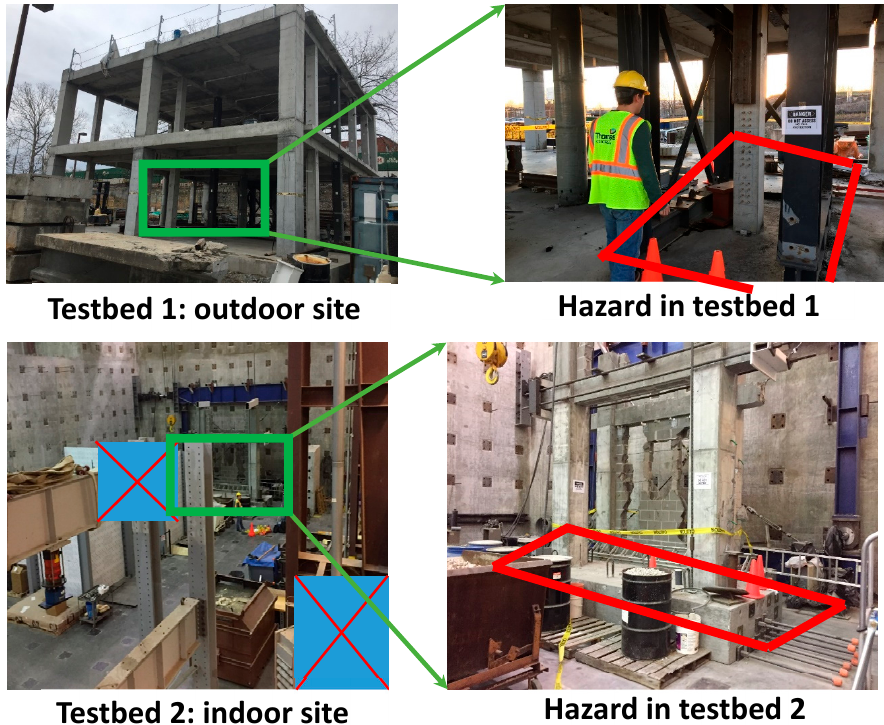
Figure 5. Two testbeds and their hazardous areas.